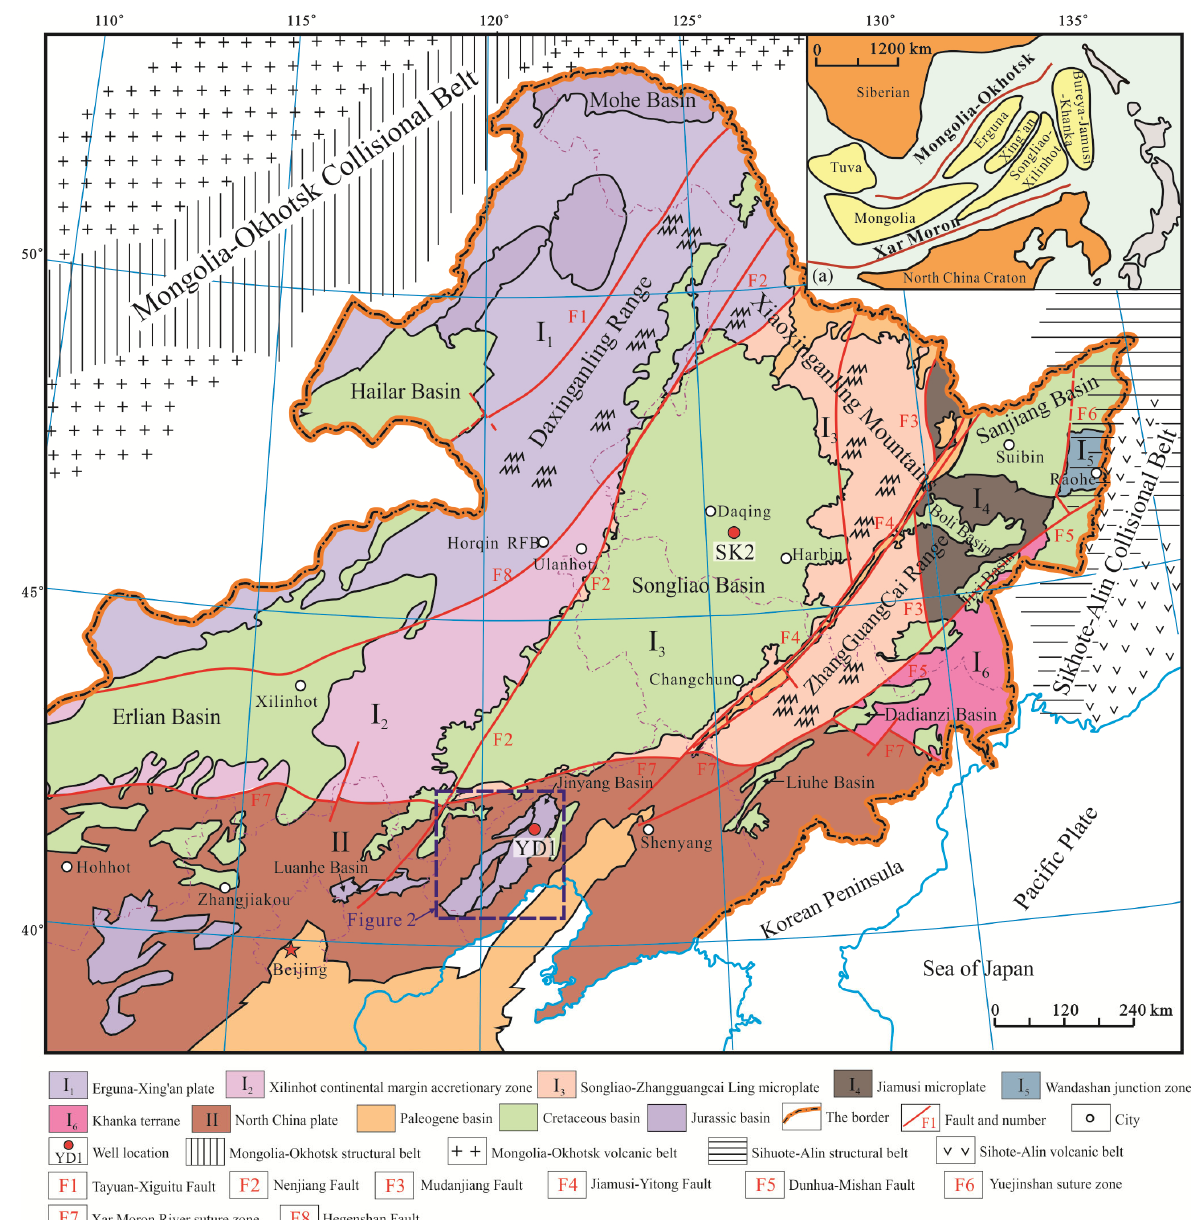
Figure 1. Simplified geological map of northeast China showing the geological tectonic units and location of the study area. ( a ) Tectonic sketch map showing the main subdivisions of eastern Asia (modified after [44]).